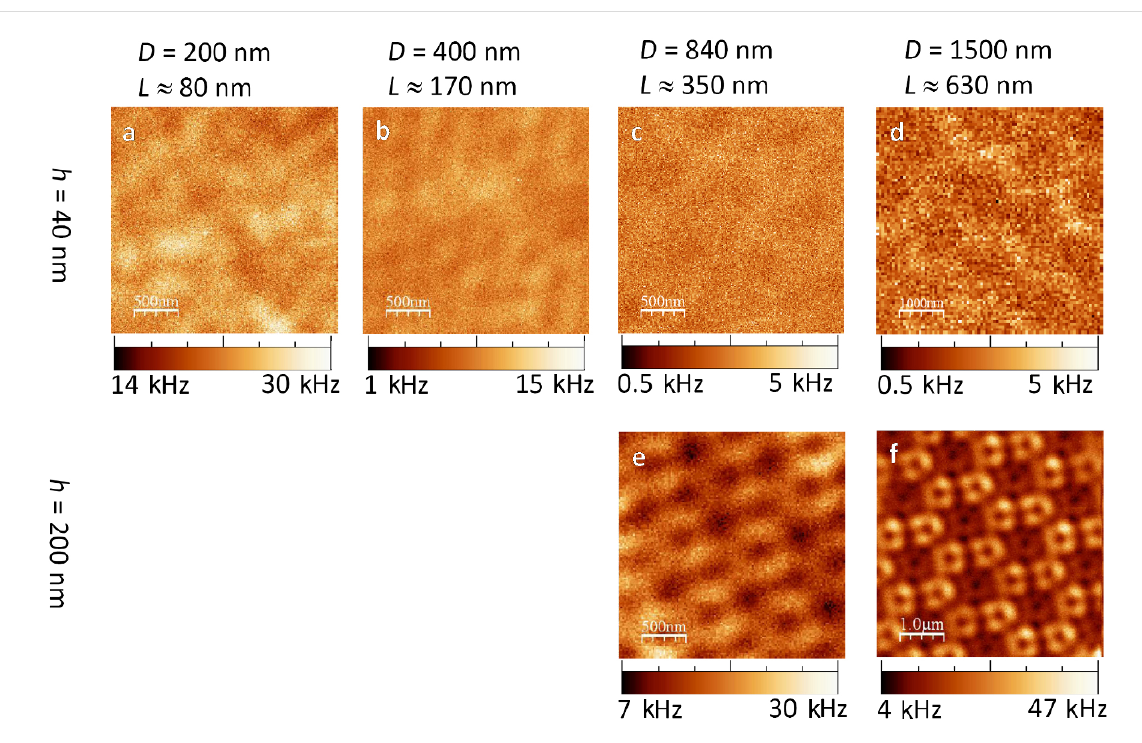
Figure 4: Confocal luminescence patterns of gold nano-triangles on silicon excited by an azimuthally polarised laser beam . Note the larger scales of (d) and